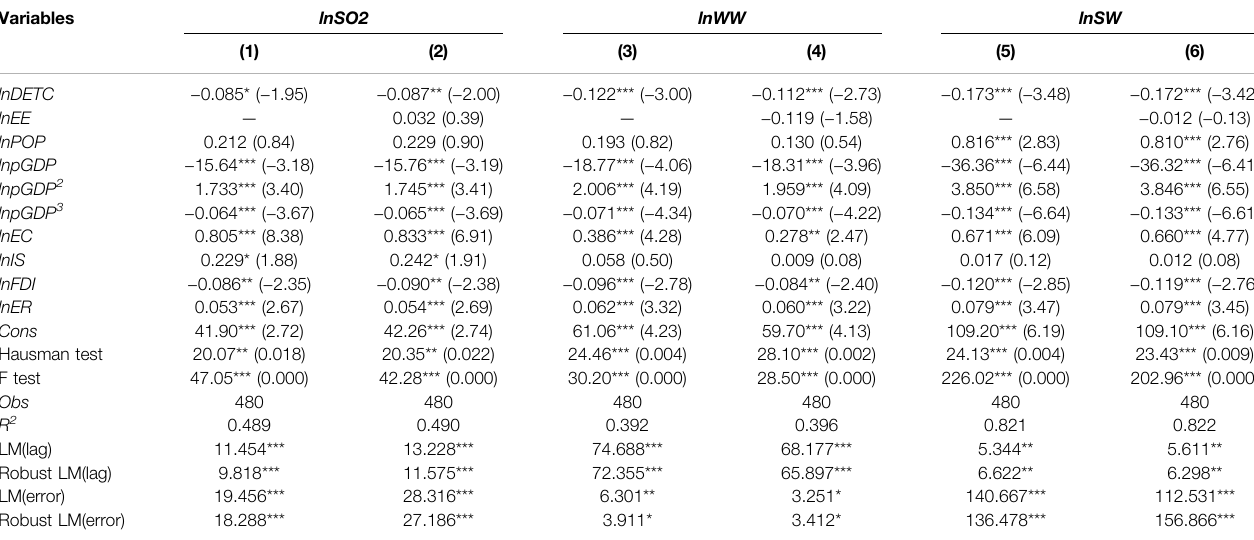
TABLE 2 | Results of SO2 , WW , and SW in the baseline model.